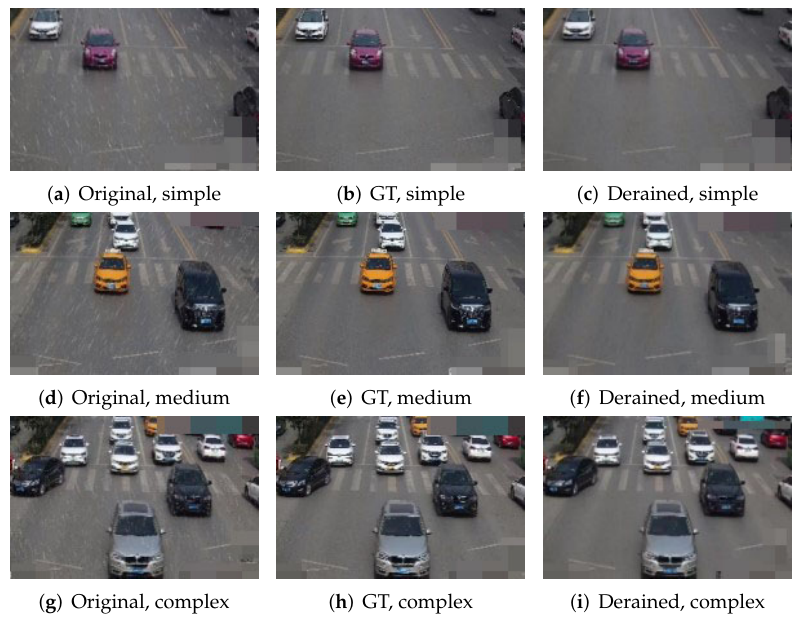
Figure 17. Test results of LDVS 2 on rain image from Rain Vehicle Color -24 test subset. The first column is the original rainy vehicle image, the second is the clean background image (GT), and the third is the one after LDVS 2. The image in the first row is in a simple scene, the one in the second row is in a medium complexity scene, and the one in the last row is in a complex